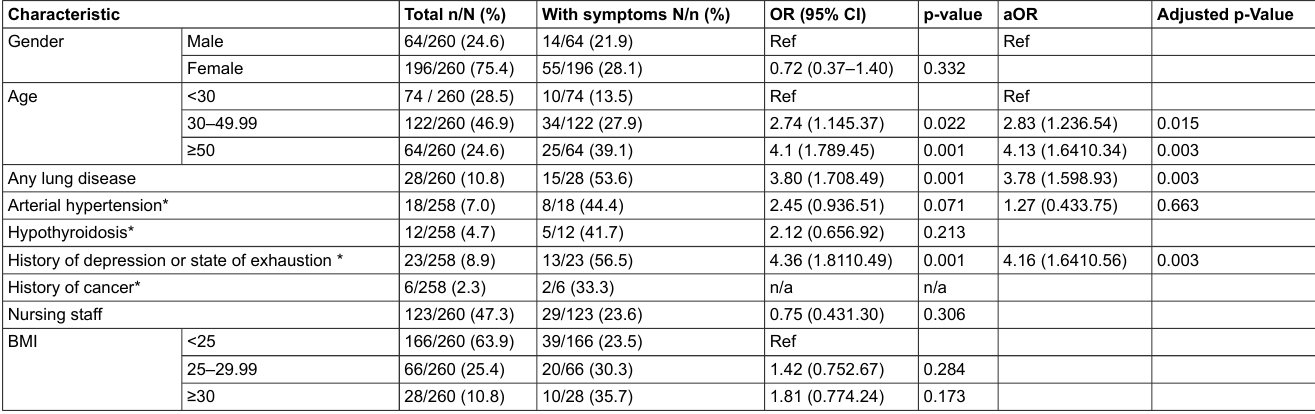
OR: odds ratio; aOR: adjusted odds ratio: CI: confidence interval, Ref: reference. Multivariable model adjusted for: age group, any lung disease, hypertension and history of depression or state of